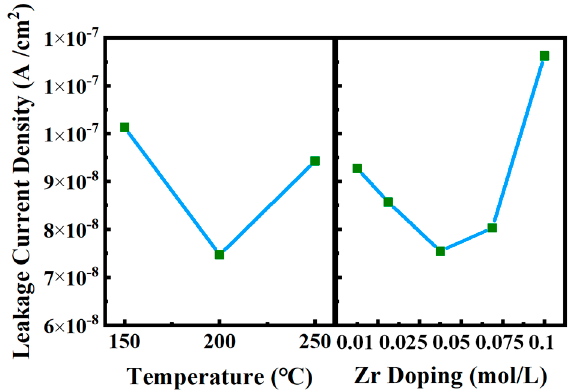
Figure 10. Main e ff ects plot of Zr–AlO x leakage current Figure 10. Main effects plot of Zr–AlO x leakage current density.